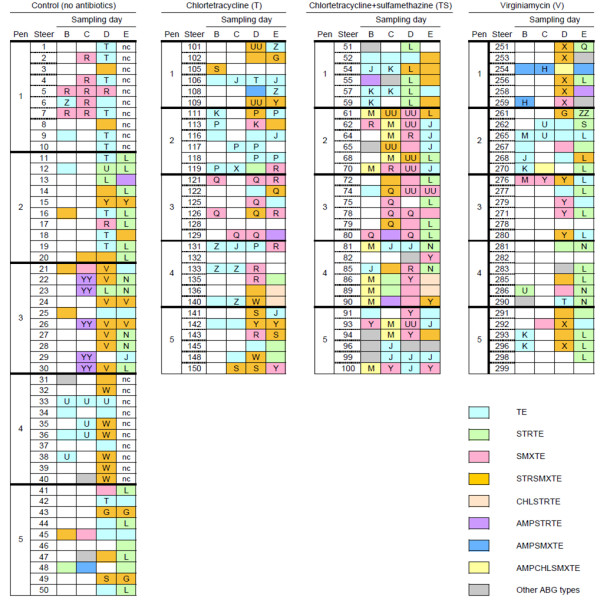
Antibiogram and PFGE types of fecal E. coli isolated from feedlot cattle using MacConkey agar amended with 4 μg/ml chlortetracycline (MT), as distributed by dietary treatment, sampling day and animal of origin. Sampling days (B to E) are depicted in Figure 1. Each box represents a single isolate from a particular steer on a given sampling day. The first eight colors represent the most commonly observed antibiogram patterns with grey indicating an infrequently observed antibiogram. Unfilled boxes indicate no isolate obtained on MT. Common letters indicate isolates with >90% genetic homology. Shaded boxes without a letter indicate isolates with <90% genetic homology with antibiogram data. Dietary treatments were as follows: Control: no antibiotics; Chlortetracycline (11 ppm; denoted T); Chlortetracycline + sulfamethazine (44 ppm; denoted TS); and Virginiamycin (31 ppm; V). nc: isolates not characterized.